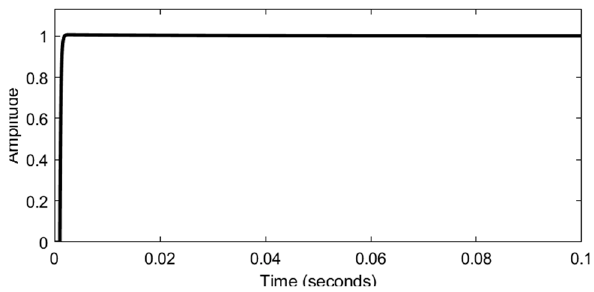
Figure 5. Steady state is achieved at 1 ms (step response) of the compensated SEPIC .